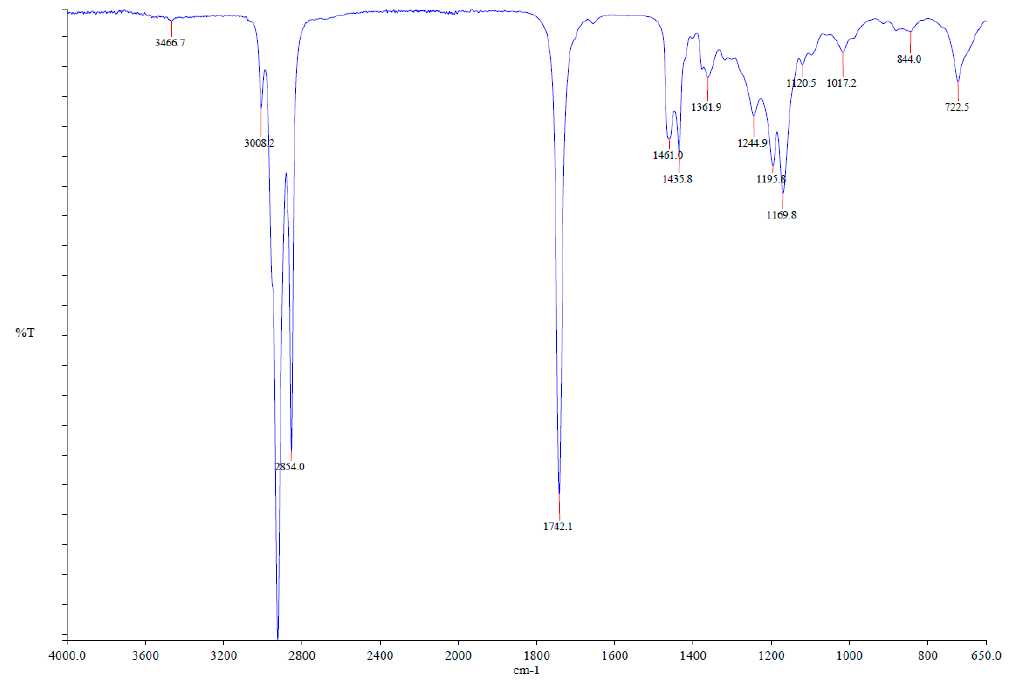
Figure 2. PSO methyl ester investigation Fourier Transform Infrared (FTIR) spectrum.